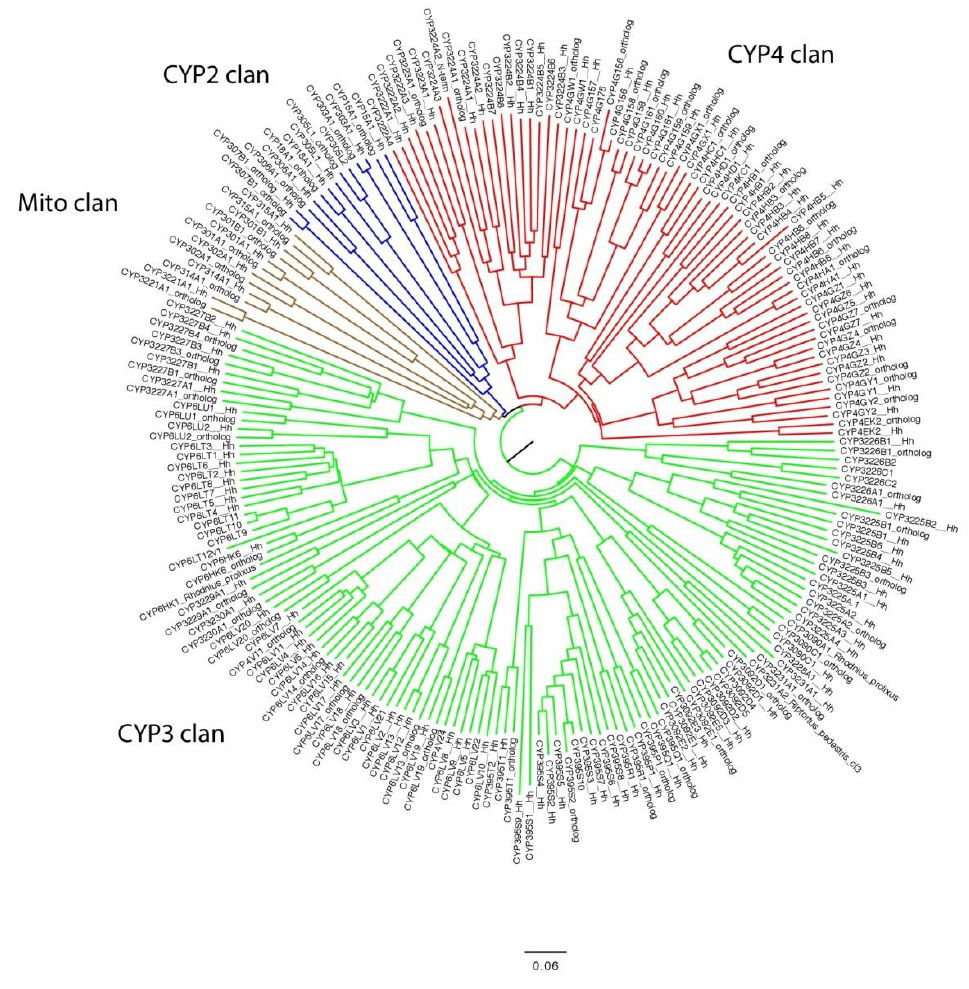
Figure 5. Cytochrome P450s from H. halys (126 sequences) and M. histrionica (86 sequences) plus two from Rhodnius prolixus and one from Riptortus pedestris were aligned using Clustal Omega (http://www.ebi.ac.uk/Tools/msa/clustalo/) at EBI. An NJ midpoint-rooted tree was made. The tree was drawn using Figtree v1.3.1 and labeled in Adobe Illustrator CC ver17.0.0. P450 clans are colored. Sequences less than 175 amino acids were not included.